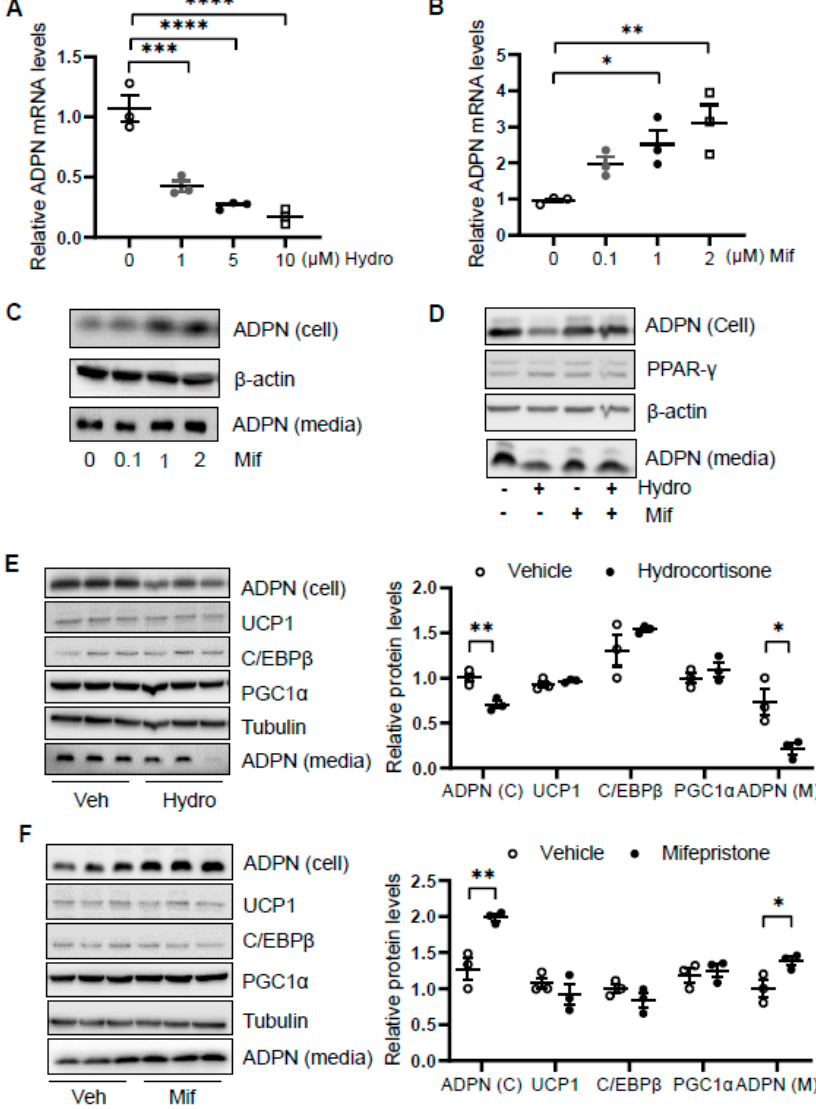
Figure 4. Glucocorticoid receptor signaling transcriptionally suppresses adiponectin in adipocytes. Differentiated 3T3-L1 adipocytes or brown adipocytes were treated with hydrocortisone or mife- pristone for 24 h at indicated concentrations. For the co-treatment, 3T3-L1 adipocytes were pre- treated by 2 μ M mifepristone for 1 h followed by the co-treatment of 2 μ M hydrocortisone. ( A ) Hydrocortisone treatment suppressed adiponectin mRNA levels in differentiated 3T3-L1 adipo- cytes in a dose-dependent manner. White dots, vehicle group ( n = 3); gray dots, 1 μ M hydrocortisone group ( n = 3); black dots, 5 μ M hydrocortisone group ( n = 3); and white square, 10 μ M hydrocorti- sone group ( n = 3). Treatment with GC receptor antagonist mifepristone upregulated adiponectin in both mRNA level ( B ) and protein expression/secretion ( C ) in a dose-dependent manner in differen- tiated 3T3-L1 adipocytes. White dots, vehicle group ( n = 3); gray dots, 0.1 μ M mifepristone group ( n = 3); black dots, 1 μ M mifepristone group ( n = 3); and white square, 2 μ M mifepristone group ( n = 3). ( D ) The suppressing effect of hydrocortisone on adiponectin expression and secretion was re- stored by mifepristone treatment in 3T3-L1 adipocytes. ( E ) Hydrocortisone treatment suppressed expression and secretion of adiponectin but had no significant effects on the expression of thermo- genesis genes in the differentiated brown adipocytes. White dots, vehicle group ( n = 3); black dots, hydrocortisone group ( n = 3). ( F ) Mifepristone treatment induced the expression and secretion of adiponectin without significant effects on the expression of thermogenesis genes in the differenti- ated brown adipocytes. White dots, vehicle group ( n = 3); black dots, mifepristone group ( n = 3). Veh, vehicle. Hydro, hydrocortisone. Mif, mifepristone. The data in Figure 4A,B,E,F are presented as the mean ± S.E.M. * p < 0.05, ** p < 0.01, *** p < 0.001, **** p < 0.0001.